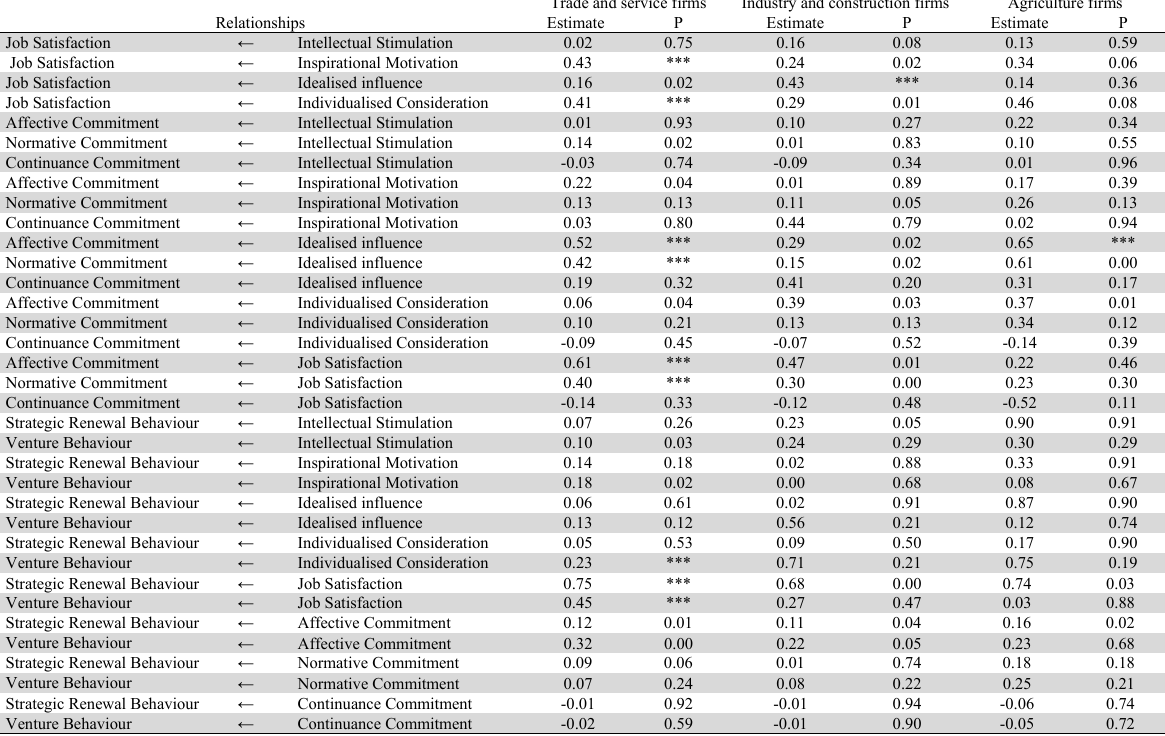
Table 5 Results of the multi-group structural analysis among firm